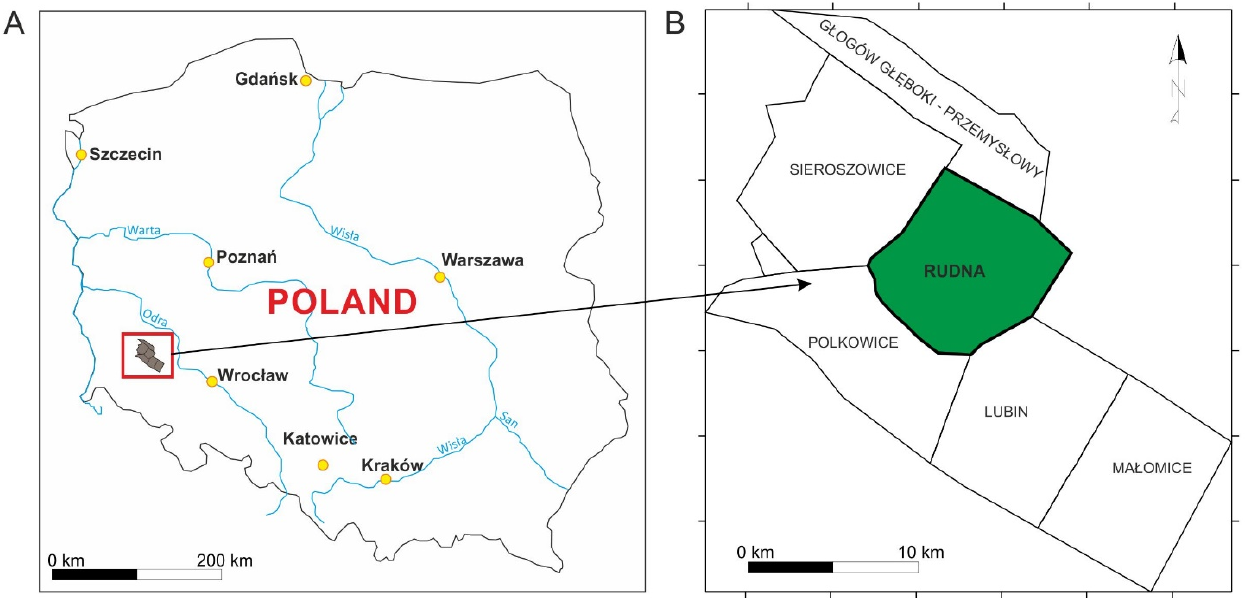
Figure 1. Location of the Cu-Ag deposits of the Legnica-G ł ogów Copper District against the background of Poland ( A ). Location of the boundaries of the Rudna deposit against the background of developed copper ore deposits in the Fore-Sudetic Monocline ( B ).